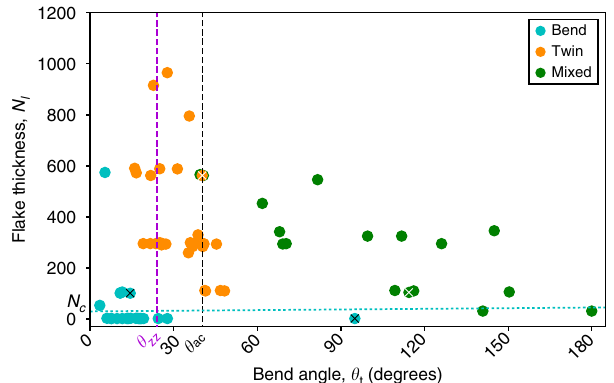
Fig. 4 Plot of observed bending phenomena in graphite. The plot demonstrates the distribution of ‘ Bend ’ , ‘ Twin ’ and ‘ Mixed ’ modes of deformation observed experimentally for different bend angles and thicknesses of crystal for both ac and zz bending. The dashed black and purple lines are the theoretically predicted ideal bend angles θ t for ac and zz twins, respectively. The theoretical minimum thickness threshold for the twin or mixed modes is denoted by the dotted blue line. The data-points derived from the illustrative images in Fig. 3 are annotated with a cross. Bend mode (blue data points) are where θ < θ t and for any thickness the crystal can accommodate the strain with gentle bending whilst remaining fully commensurate, and also where θ > θ t but the fl ake is suf fi ciently thin that deformation results in nanotube-like bending of the basal planes. Twin mode (orange data points) is where above a critical fl ake thickness N c and around or below θ t , discrete twin boundaries are found. The mixed mode (green data points) are where thicker fl akes above θ t display a third and more complex con fi guration combining twinning and